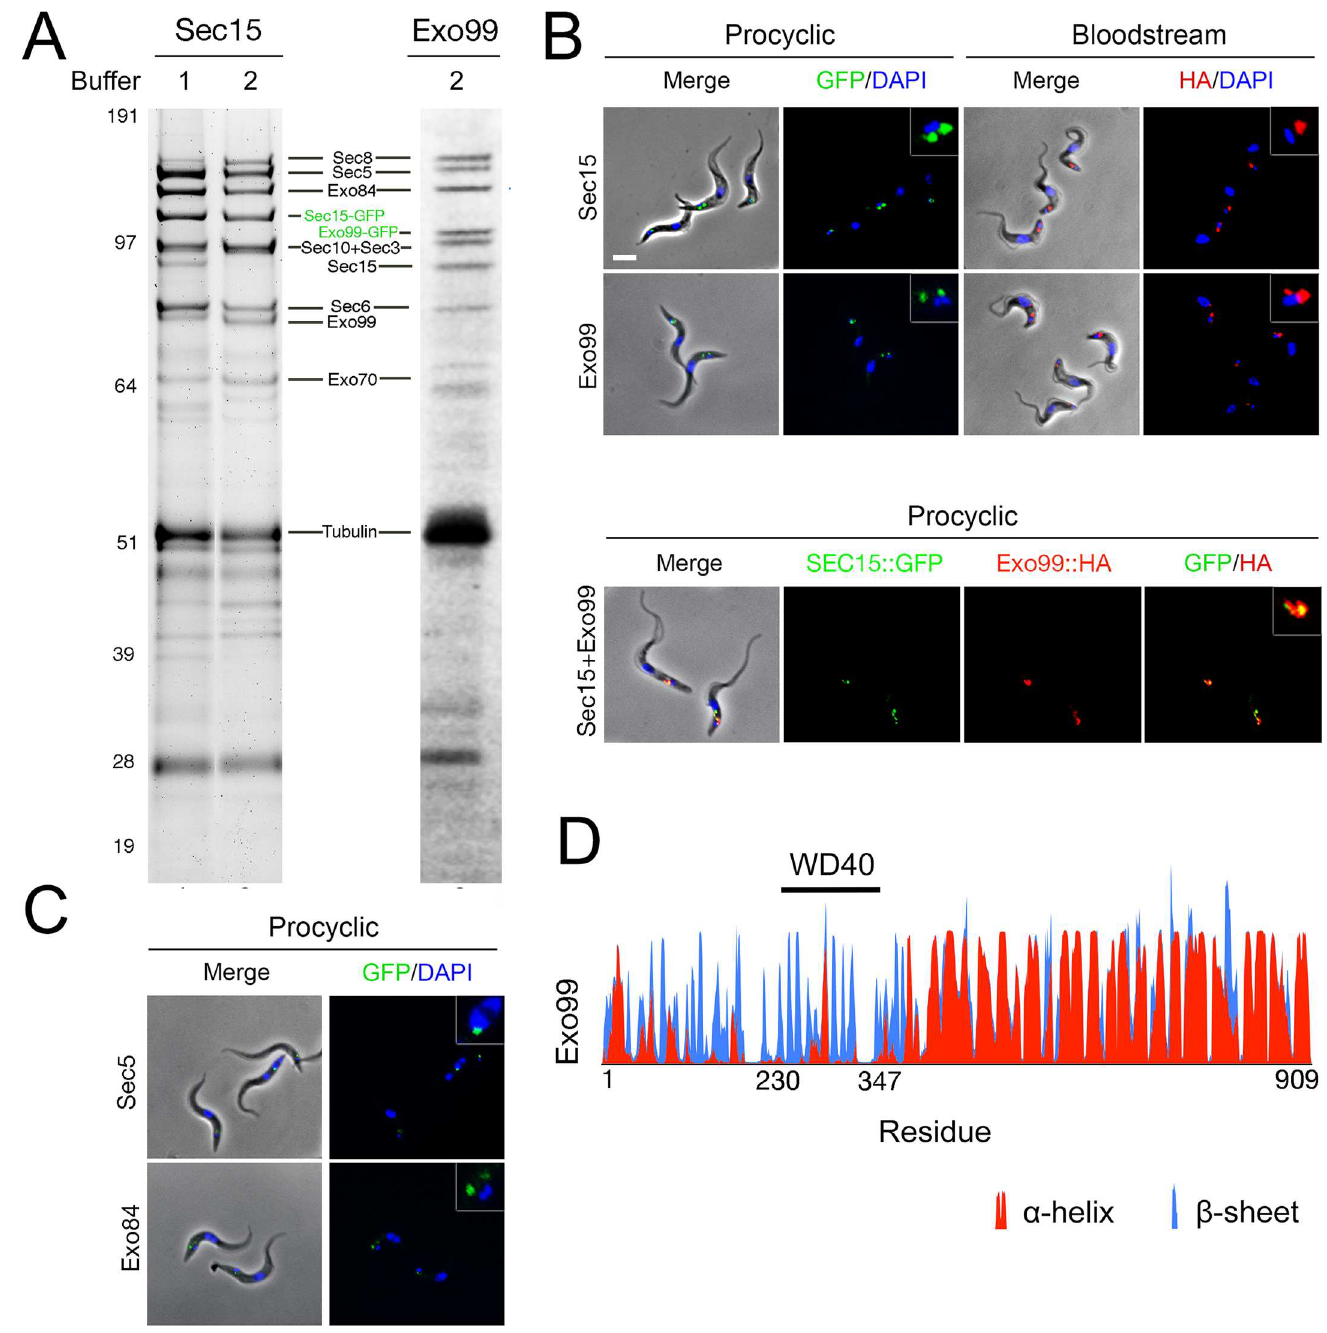
Fig 1. Identification of nine exocyst subunits in trypanosomes. (A) Immunoisolation from PCF cells constitutively expressingSec15::GFP or Exo99::GFP. Pullouts were performed with the followingbuffers; (1) 20mM HEPES pH 7.4, 500mM NaCl 5% Triton and protease inhibitors; (2) 20mM HEPES pH 7.4, 250mM NaCitrate 5% CHAPS and protease inhibitors. (B) Immunofluorescence microscopy of PCF cells expressingSec15::GFP and Exo99::GFP (green), BSF cells expressingSec15::HA and Exo99::HA (red) and PCF cells co-expressing Sec15::GFP and Exo99::HA. DAPI was used to visualiseDNA (blue). Scale bar, 5 μ m. In both lifecycle stages Sec15 and Exo99 localiseto the regionbetweenthe nucleusand kinetoplast where the organellesof the endocytic and secretory pathwaysare found. (C) Immunofluorescence of PCF cells expressingSec5::GFP and Exo84::GFP (green). Sec5 and Exo99 localise to the same region which indicatesthat they are part of the same complex. (D) Predicted secondary structure of Exo99 accordingto PSIPRED. The horizontal black line represents the polypeptide span with the N-terminus to the left, the y-axis indicatesthe confidence score of predictedsecondary structure. Predicted α -helixare shownin red, predicted β -sheetin blue.